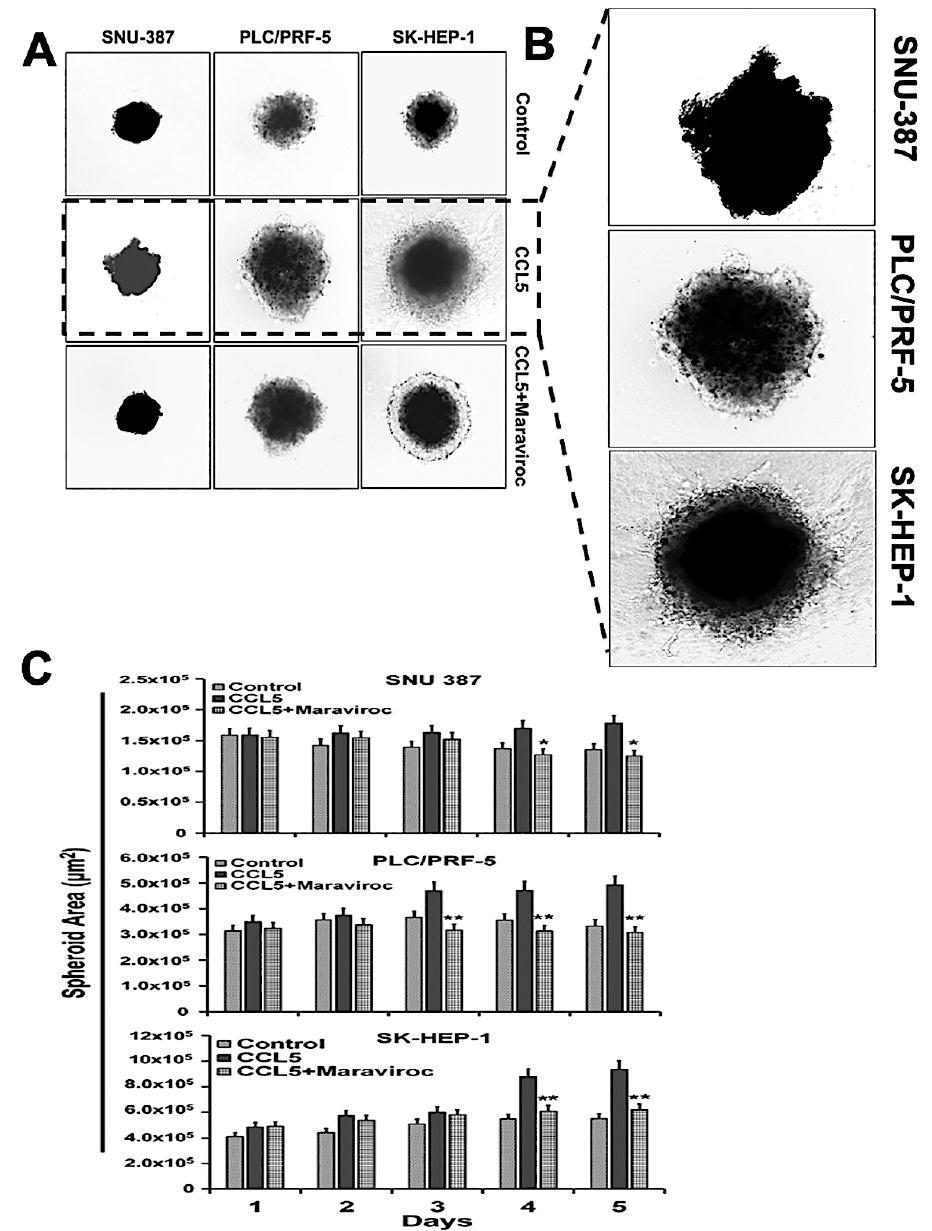
Figure 7. Treatment with the CCR5 antagonist maraviroc blocks the migration and invasion of HCC cells. ( A ) Three-dimensional morphology of invading cells over a 5-days for HCC cells untreated and treated with maraviroc. ( B ) Representative images showing CCL5-induced migration and invasion of liver cancer cells. ( C ) Quantitative surface area analysis of HCC cells over 5-days. The experiments were repeated three times. Bar graphs are presented as a change in surface area in expression (±standard error); the asterisks indicate p values (* p < 0.05 ** p < 0.01).